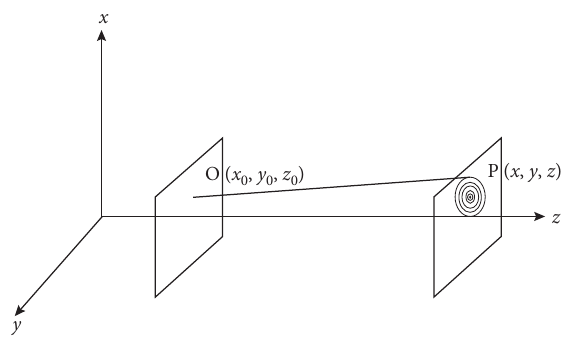
Figure 1: Fresnel holography for a